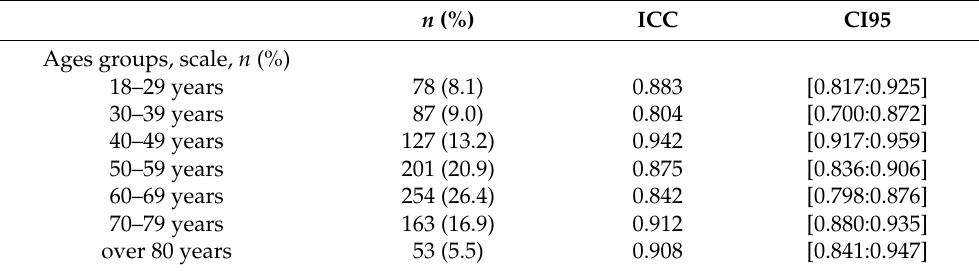
Table 2. Intersystem concordance between rPPGc and gold standard as a function of age. n (%) ICC CI95 Ages groups, scale, n (%)